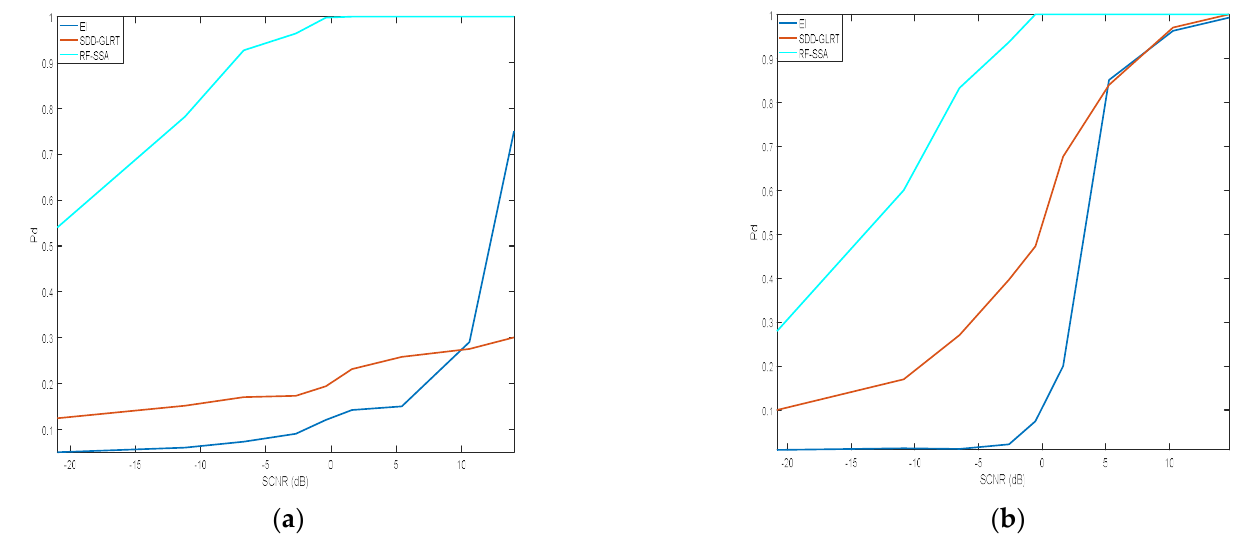
Figure 6. Detection performance comparisons of different detectors: ( a ) v = 0.1; ( b ) v = 0.5.